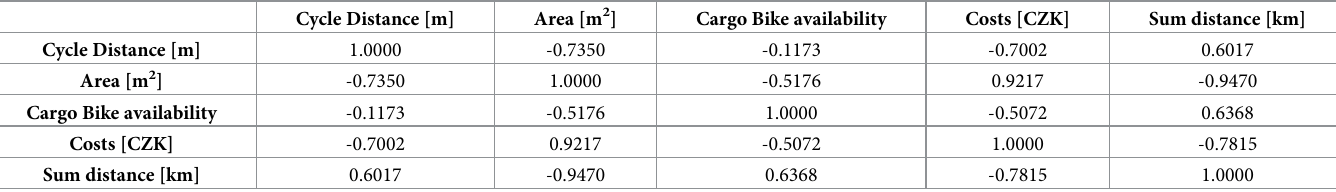
Table 14. Formulation of the mxm criteria matrix.